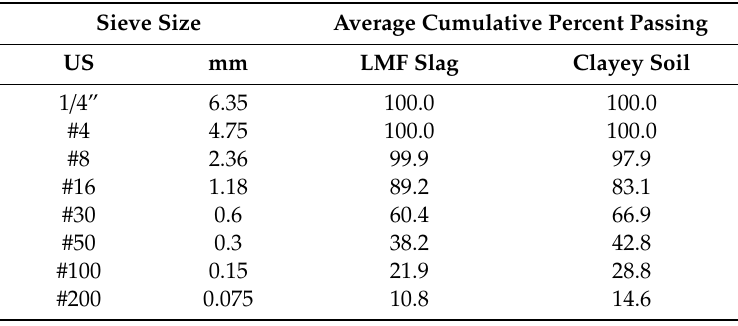
Table 1. Average gradations of the LMF slag and clayey soil.